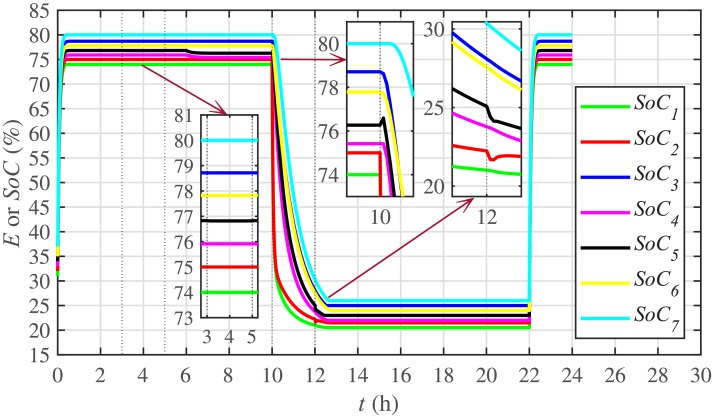
SoC tracking under case 2.